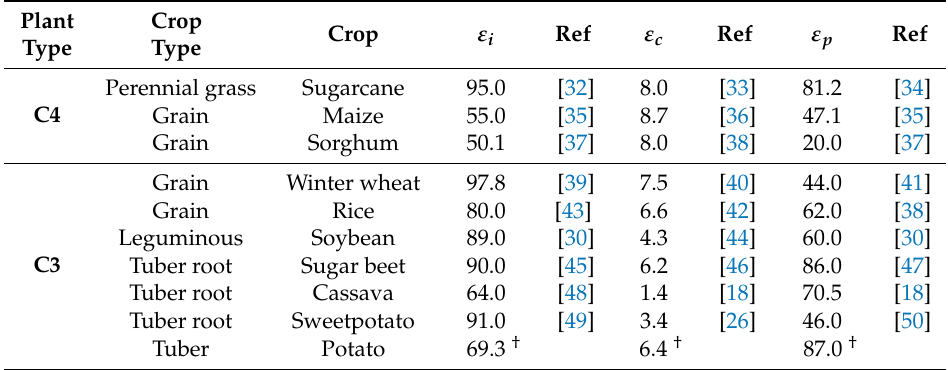
Table 5. Maximum values of efficiencies reported in the literature, for worldwide major crops according to FAO. Ref =